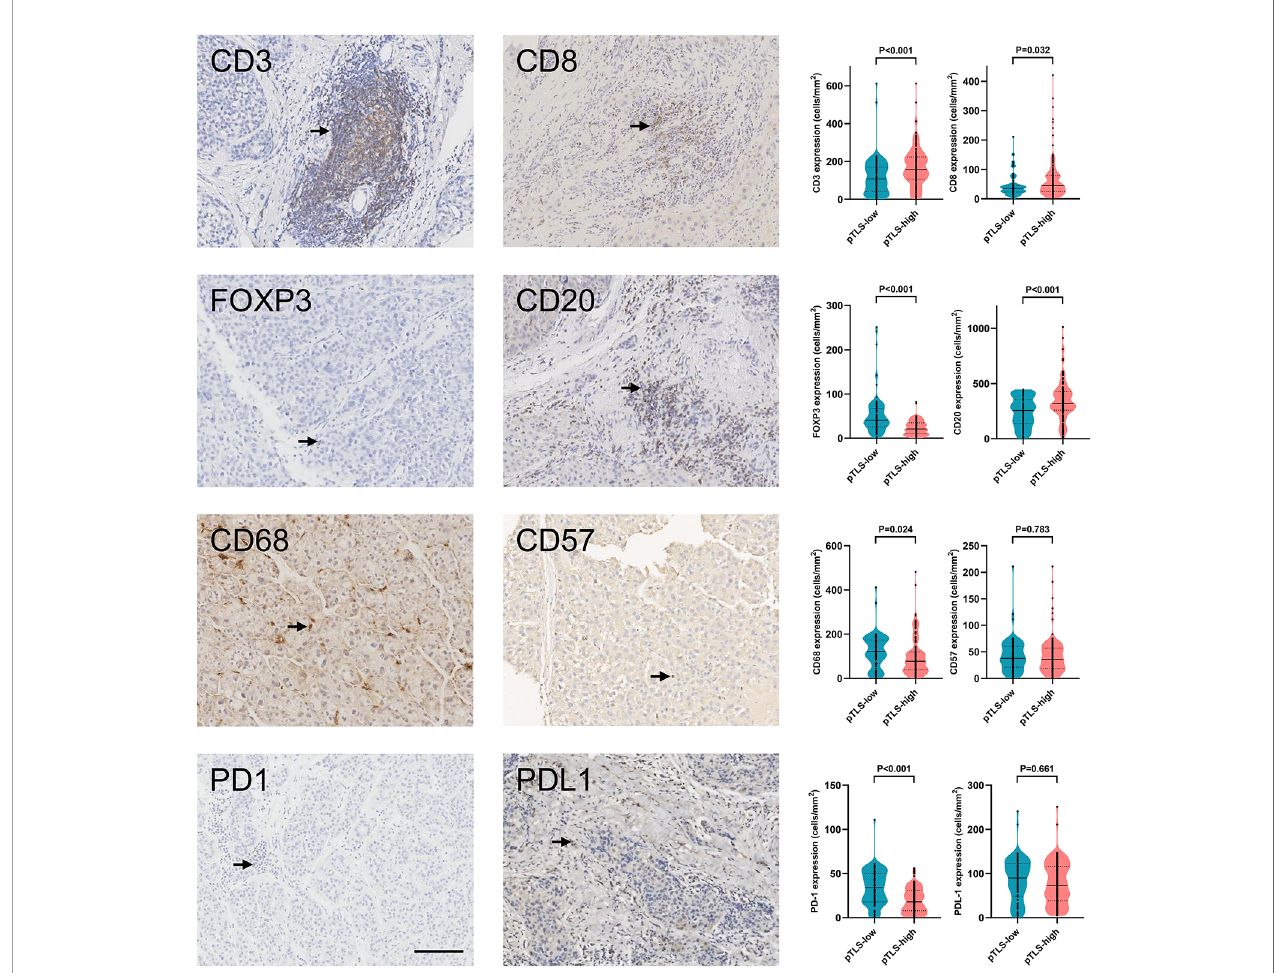
FIGURE 5 | pTLS density correlates with tumor-in fi ltrating immune cells. Representative images of main tumor-in fi ltrated immune cells (left panel) and relative statistical analyses (right panel) of tumors with low or high pTLS densities. Black arrows represented positive staining. Groups were statistically compared using Mann – Whitney U-test. Scale bar, 100 m m. iTLS, intratumoral tertiary lymphoid structure; pTLS, peritumoral tertiary lymphoid